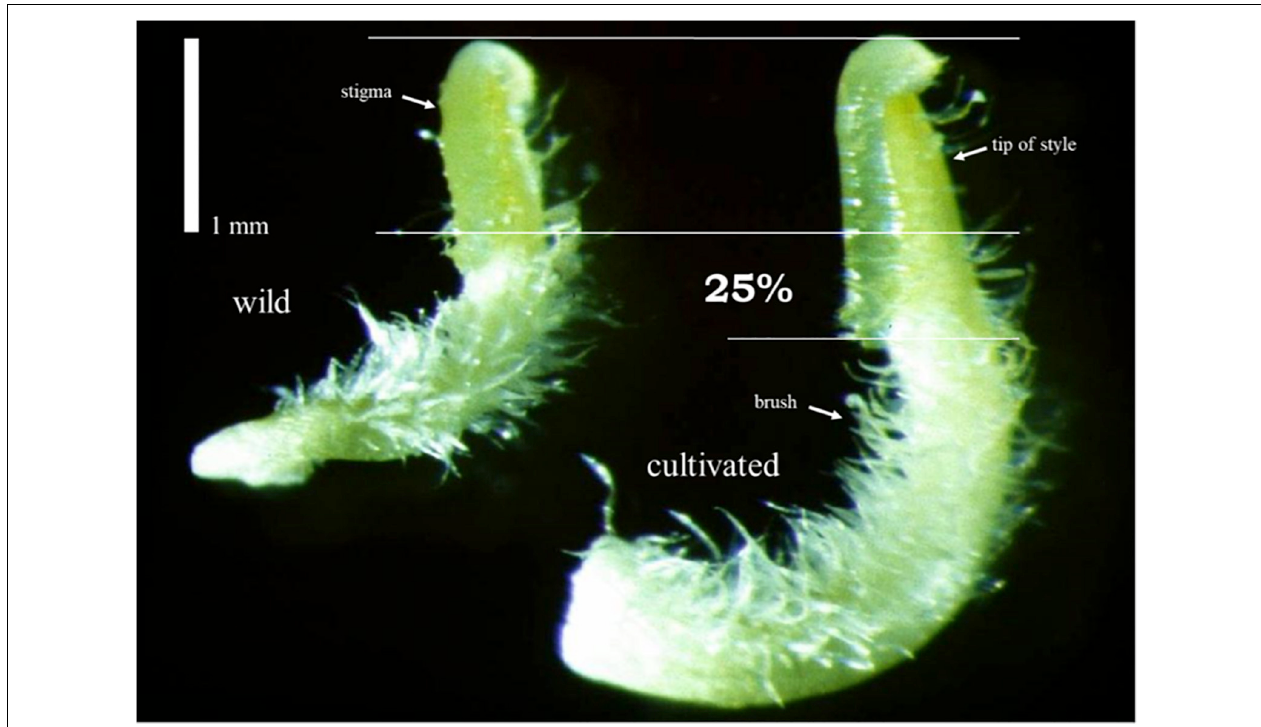
FIGURE 6 | Comparison of tips of styles and stigmas in wild (left) and cultivated (right) P. vulgaris . The stigma area is bigger in the cultivated form and expands toward the internal part of the keel (to the left in both cases) (photograph by D.G. Debouck).